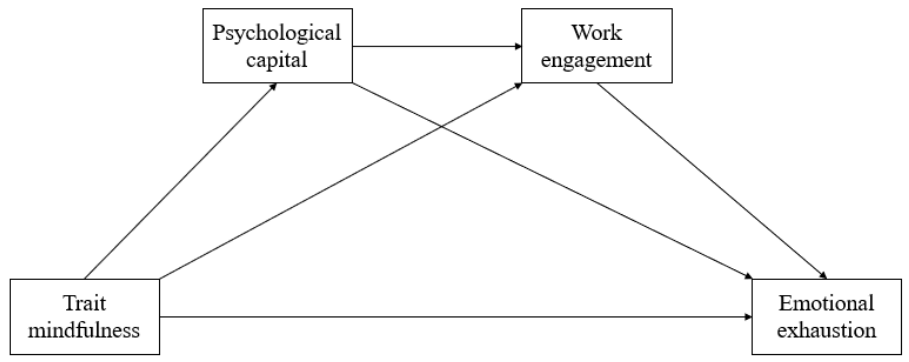
Figure 1. Chain mediating model.